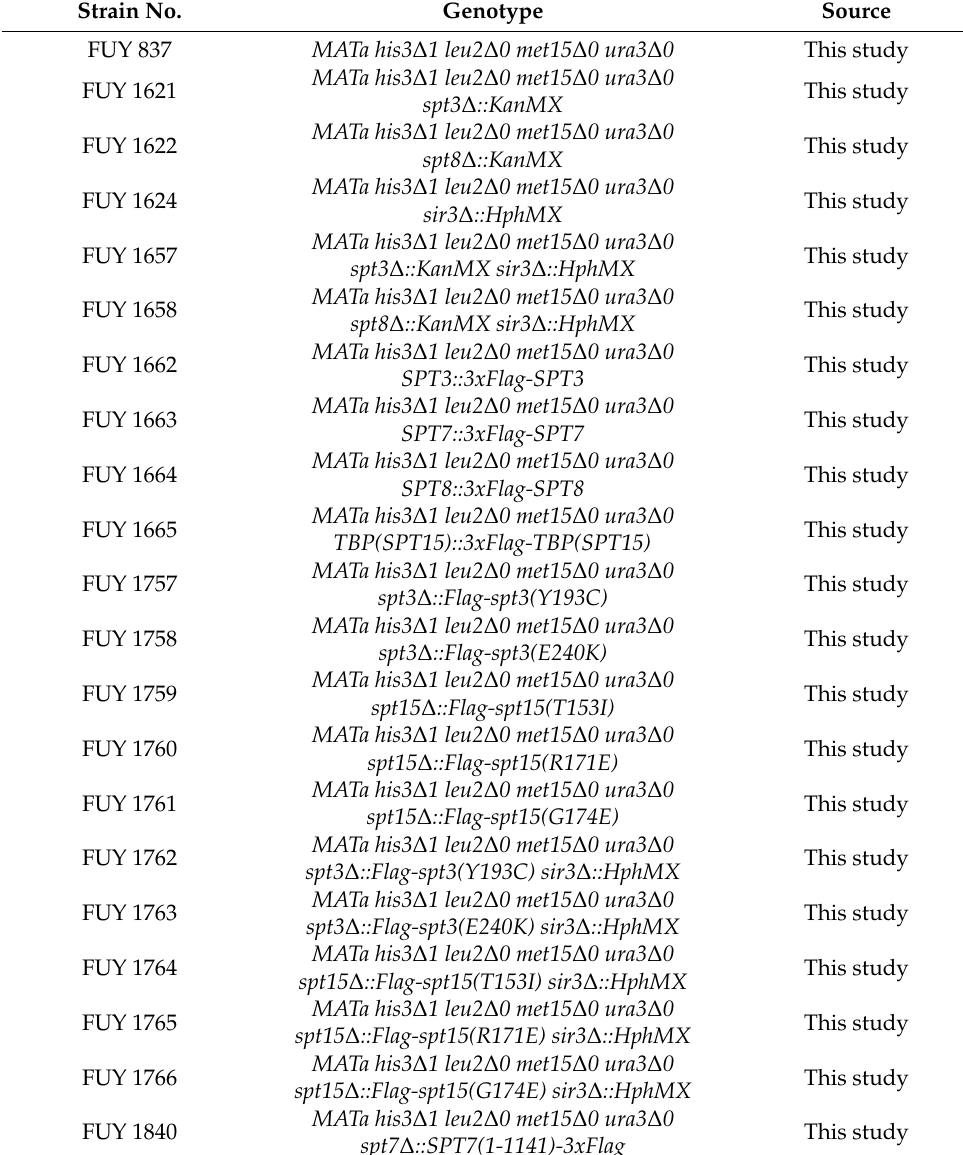
Table 1. Yeast strain list. Strain No.